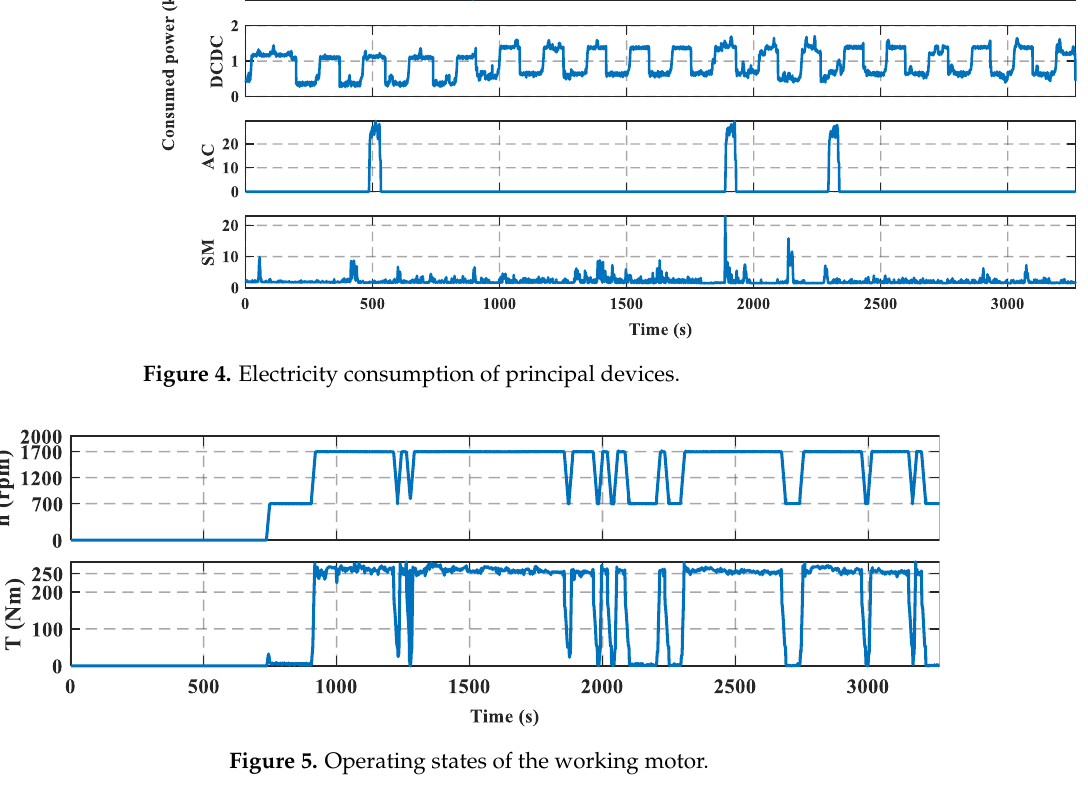
Figure 4. Electricity consumption of principal devices.